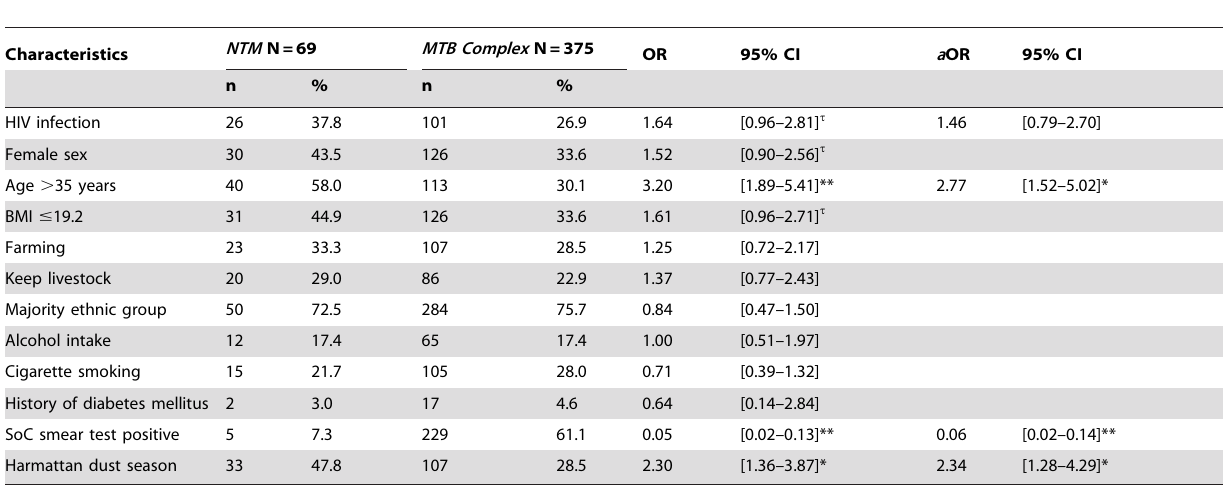
Table 3. Comparison of characteristics between NTM and MTB Complex cases visiting two tuberculosis treatment sites in northern Nigeria from August 2010 to July